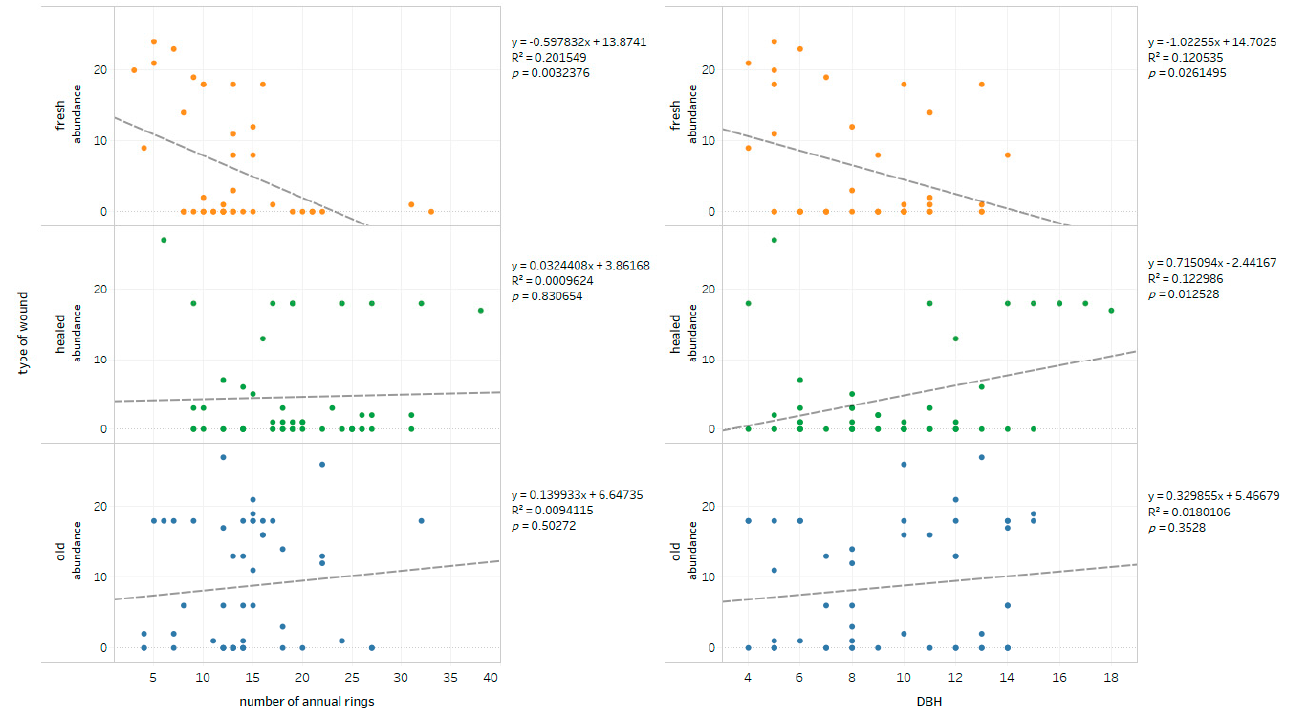
Figure 6. Linear regression of fungal colony abundance on three types of bark wounds against the number of annual rings and DBH of investigated silver fir trunks.